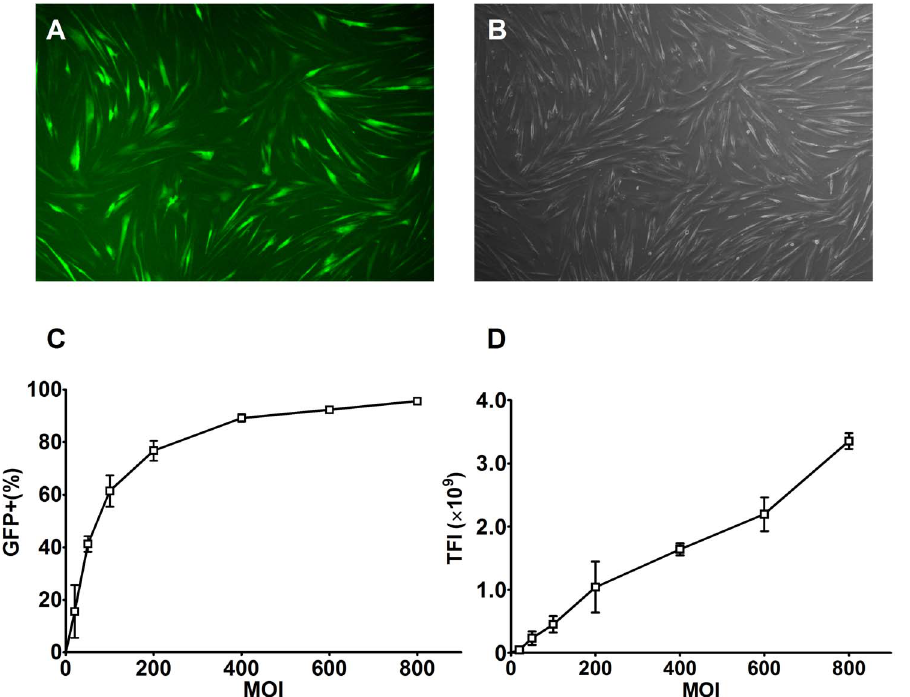
Figure 1. Infection efficiency of recombinant baculovirus in hUCB-MSCs. A and B : Fluorescence and bright field microscopy images of hUCB-MSCs, respectively, which were seeded at 1 6 10 5 cells per well and infected with Bac-GFP at MOI=200 (40 6 ). C and D : GFP + % and TFI of Bac- GFP-infected hUCB-MSCs at 24 hpi with different MOIs. Results are means 6 SD (n=3). Abbreviations : Bac-GFP, recombinant baculovirus carrying green fluorescence protein reporter gene; hUCB-MSCs, human umbilical cord blood mesenchymal stem cells; MOI, multiplicity of infection; GFP + %, percentage of GFP positive cells; TFI, total fluorescence intensity; SD, standard deviation.